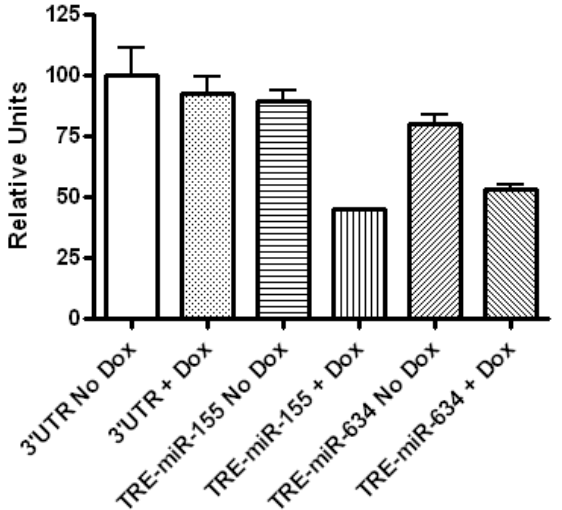
Figure S1. Inhibitory effect of induced miR-155 and miR-634 expression on cyr61 . Luciferase assay of LN229 cells transiently co-transfected with the cyr61 (cid:22)(cid:182)(cid:56)(cid:55)(cid:53)(cid:3) (cid:68)(cid:81)(cid:71)(cid:3) empty vector or with TRE3G-IRES-miRNA expressing plasmids. miRNA-expressing plasmids were under the control of a doxycycline-inducible vector. Firefly and Renilla. values were determined at 24 h post-transfection. The data represent the ratio between Renilla. values and firefly internal control for each group (n = 2).